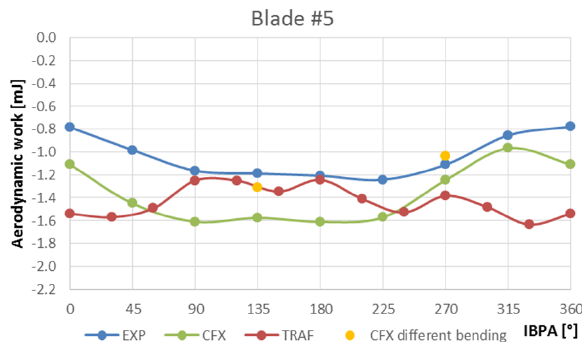
Figure 17. Aerodynamic work of blade bending motion - blade #5: experimental (EXP), CFX and TRAF